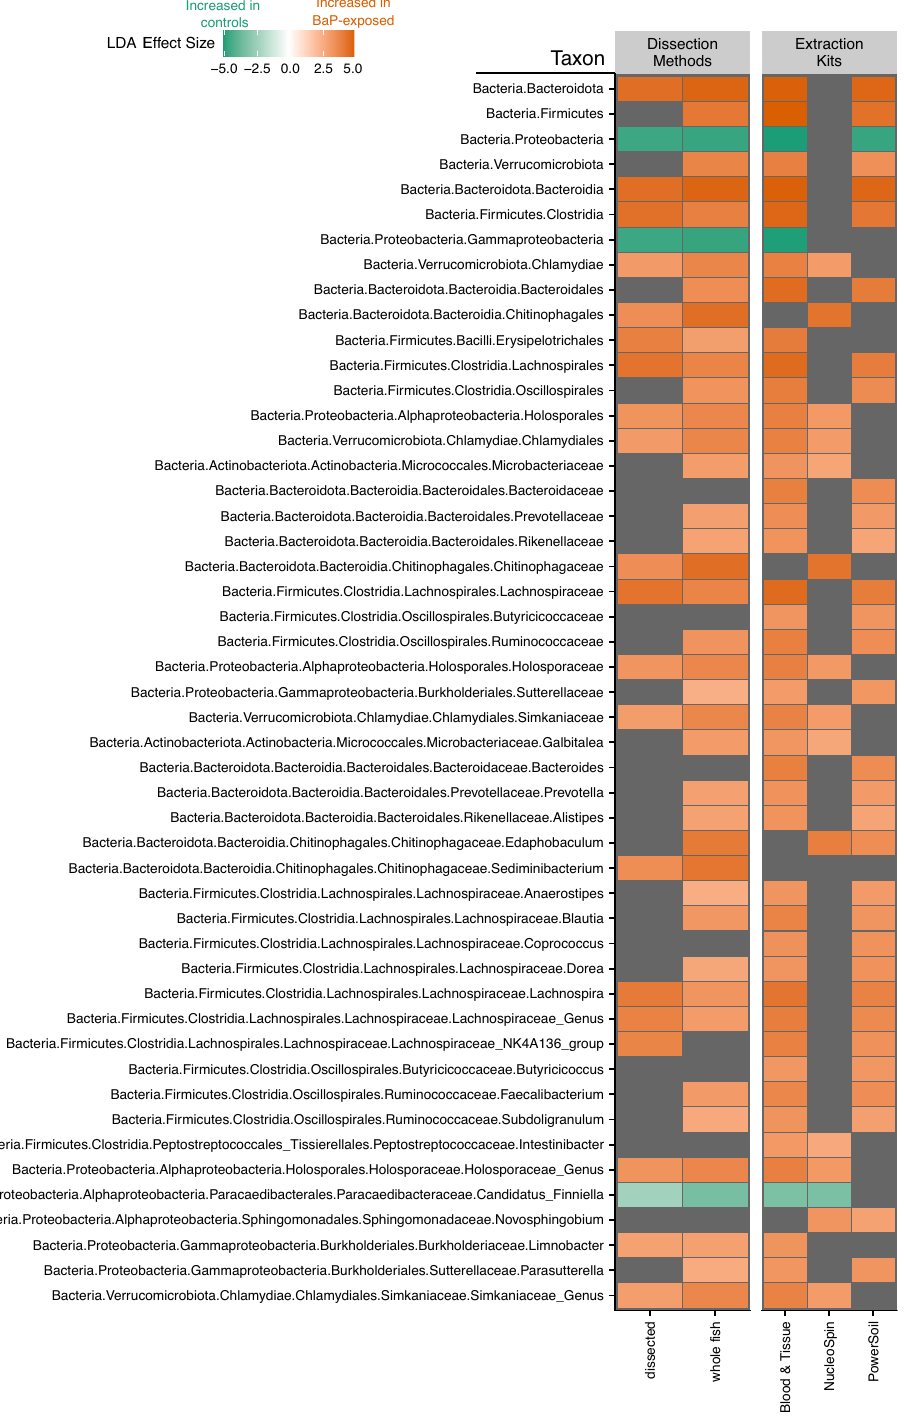
Figure 4. Heatmap of statistically significant effect sizes estimated by LEfSe. This plot only shows phylotypes that were consistently identified as indicators across at least two data sets. The color of the square indicates the effect size with green meaning a phylotype is indicative of the control (no BaP exposure) while orange means a phylotype is indicative of BaP exposure. Gray squares indicate the taxon is not an indicator for either the control or treatment for that data